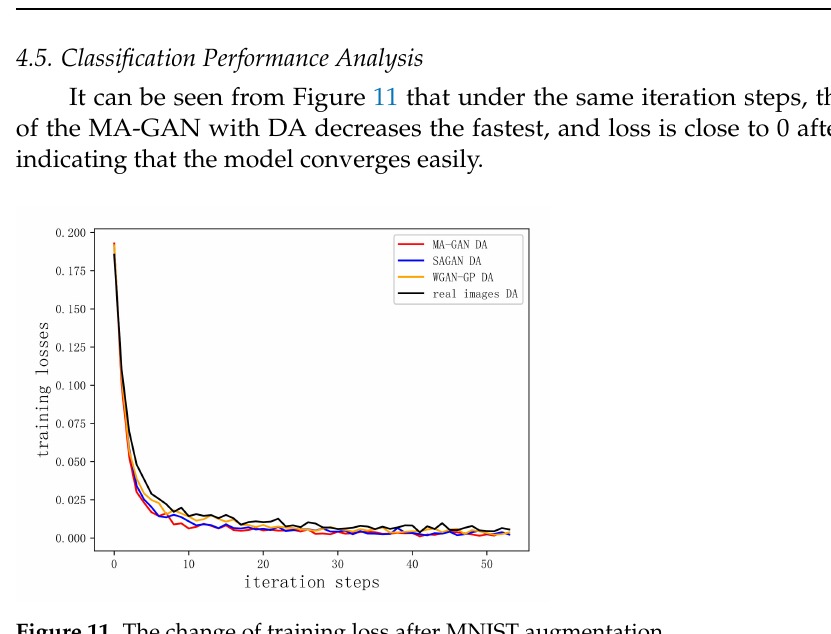
Figure 11. The change of training loss after MNIST